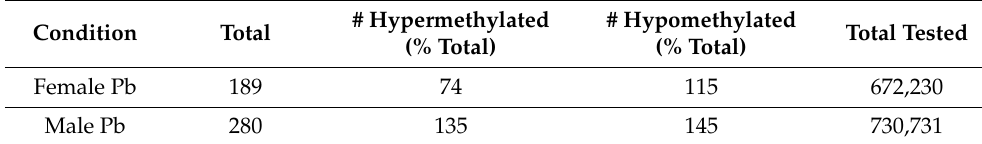
Table 1. Numbers of differentially methylated cytosines (DMCs) in weanling mouse hearts.